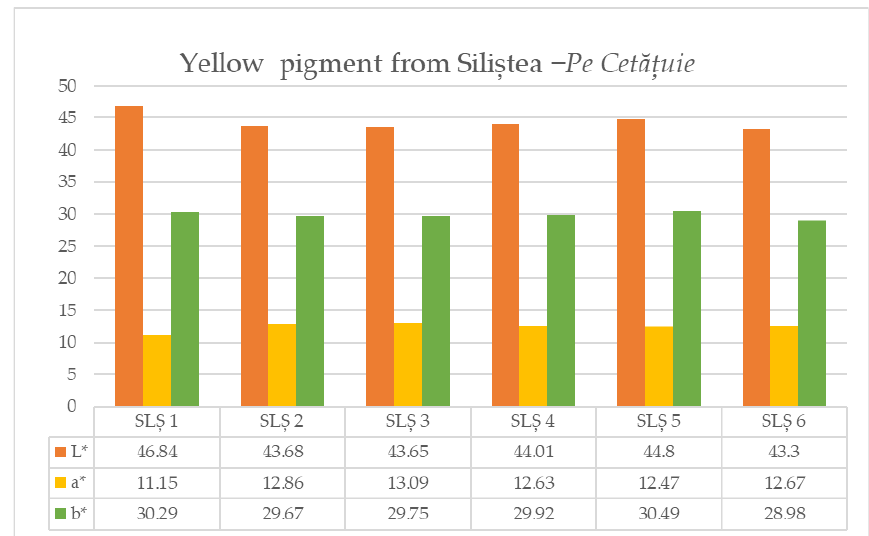
Figure 11. CIE L*a*b* colorimetry for the red pigment from Piatra Neam ț — Bâtca Doamnei.